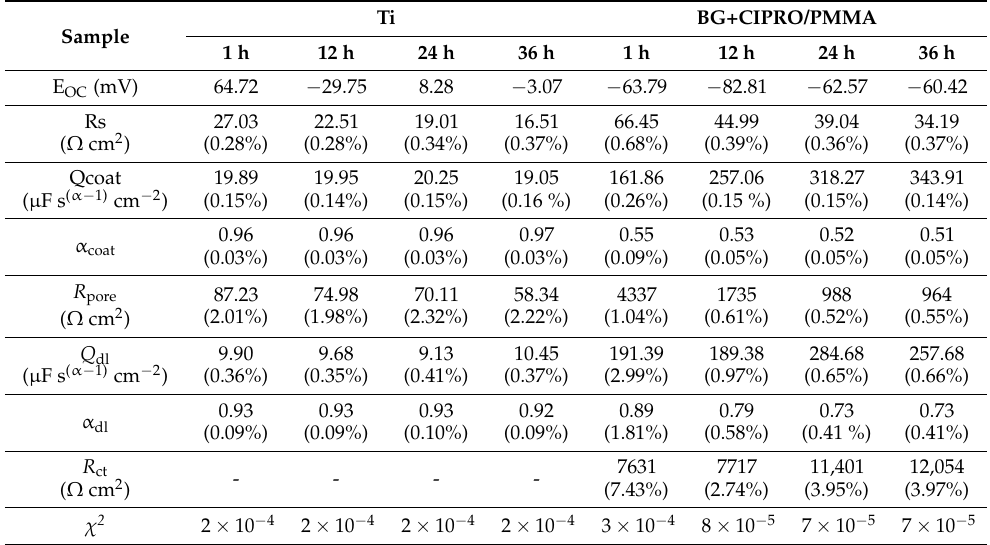
Table 3. The open circuit potential (EOC) and EIS fitted parameters with the associated relative errors of Ti and BG+CIPRO/PMMA-coated Ti after 1, 12, 24, and 36 h of immersion in SBF at 37 ◦ C.